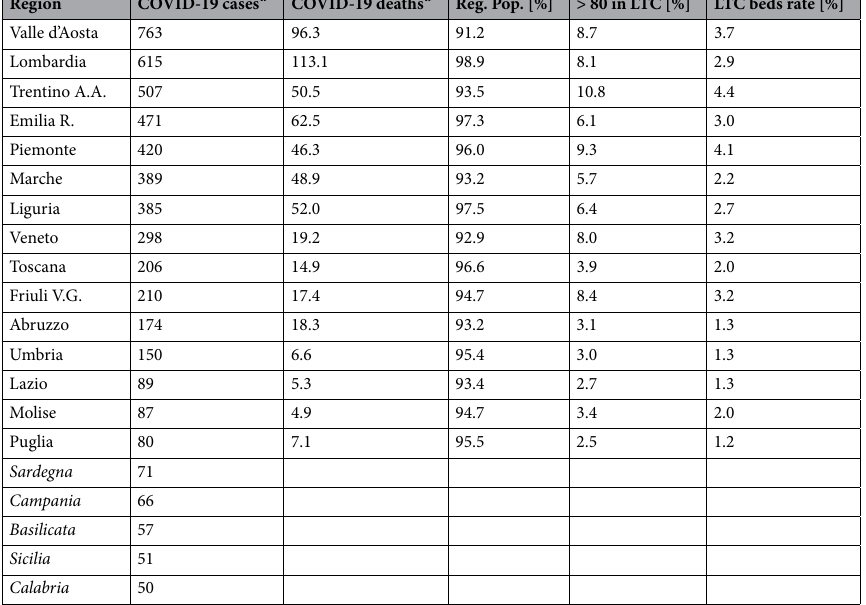
Table 1. COVID-19 cases incidence and COVID-19 deaths per 100,000 in all Italian Regions at 15th April 2020 10 ; percentage of regional population covered by municipalities reported in the mortality data-set issued a by ISTAT 33 . per 100,000 Last two columns report the percentage of over 80 in LTCFs 35 , and the LTCFs beds rate 36 . Only Regions with more the 80 cases per 100,000 are considered. (Trentino A.A.: Trentino Alto